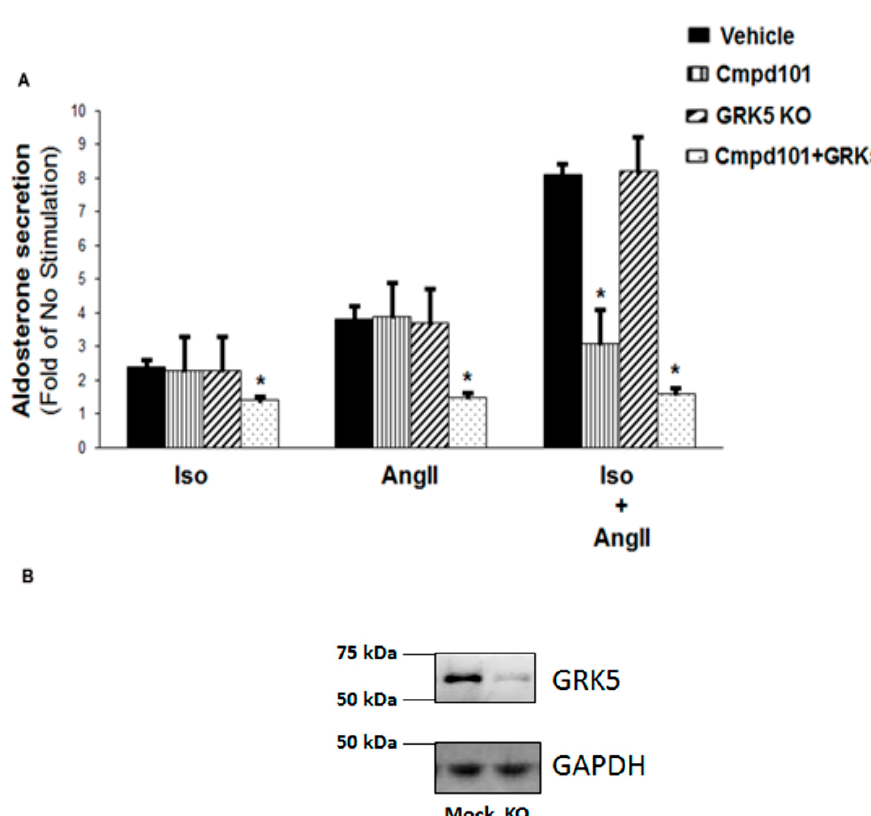
Figure 2. GRK2 mediates the synergism between β ARs and AT 1 Rs in adrenocortical zona glomerulosa (AZG) cells, leading to enhanced aldosterone production. ( A ) Aldosterone secretion was measured at 6 hr post-challenge, with 10 µ M isoproterenol alone (Iso), 100 nM AngII alone (AngII), or both (applied simultaneously) (Iso + AngII) from control (no manipulation-Vehicle) H295R cells, from cells pretreated with 30 µ M Cmpd101, from cells having GRK5 genetically deleted via CRISPR (GRK5 KO), or from cells having both GRK5 genetically deleted and pretreated with 30 µ M Cmpd101 (Cmpd101 + GRK5 KO). The data are expressed as a fold of the response to no stimulation. *, p < 0.05, vs. corresponding Vehicle; n = 5 independent experiments / treatment. ( B ) Immunoblotting for GRK5 in extracts from cultured H295R cells, transfected with control empty vector / mock lentivirus (Mock) or CRISPR human GRK5-specific lentivirus to delete the gene for GRK5 (KO). A representative blot is shown, including glyceraldehyde 3-phosphate dehydrogenase (GAPDH) as the loading control of three independent experiments performed in duplicate, confirming GRK5 deletion in KO cells.